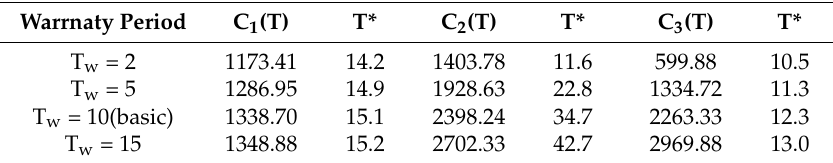
Table 8. Optimal release time T* subject to the warranty